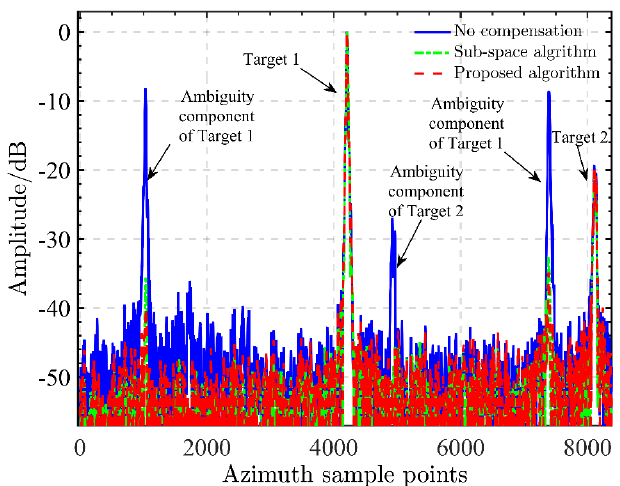
Figure 6. Azimuth profiles of ship targets from different calibrations.